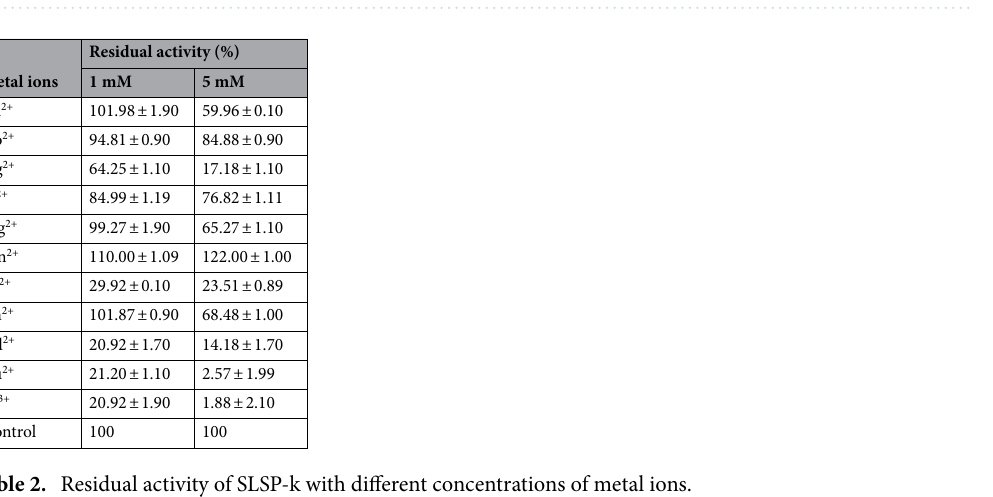
Figure 4. ( a ) FT-IR spectra of SLSP-k with casein as substrate, ( b ) Effect of temperature on activity and stability of SLSP-k, ( c ) Effect of pH on activity.